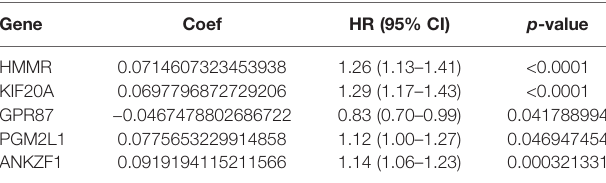
TABLE 1 | The detailed information of fi ve glycolysis-related genes for the prediction